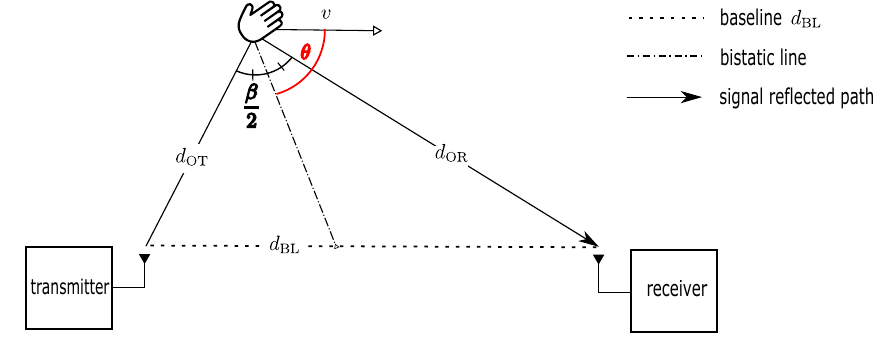
Figure 6. Geometry of bistatic Doppler radar according to